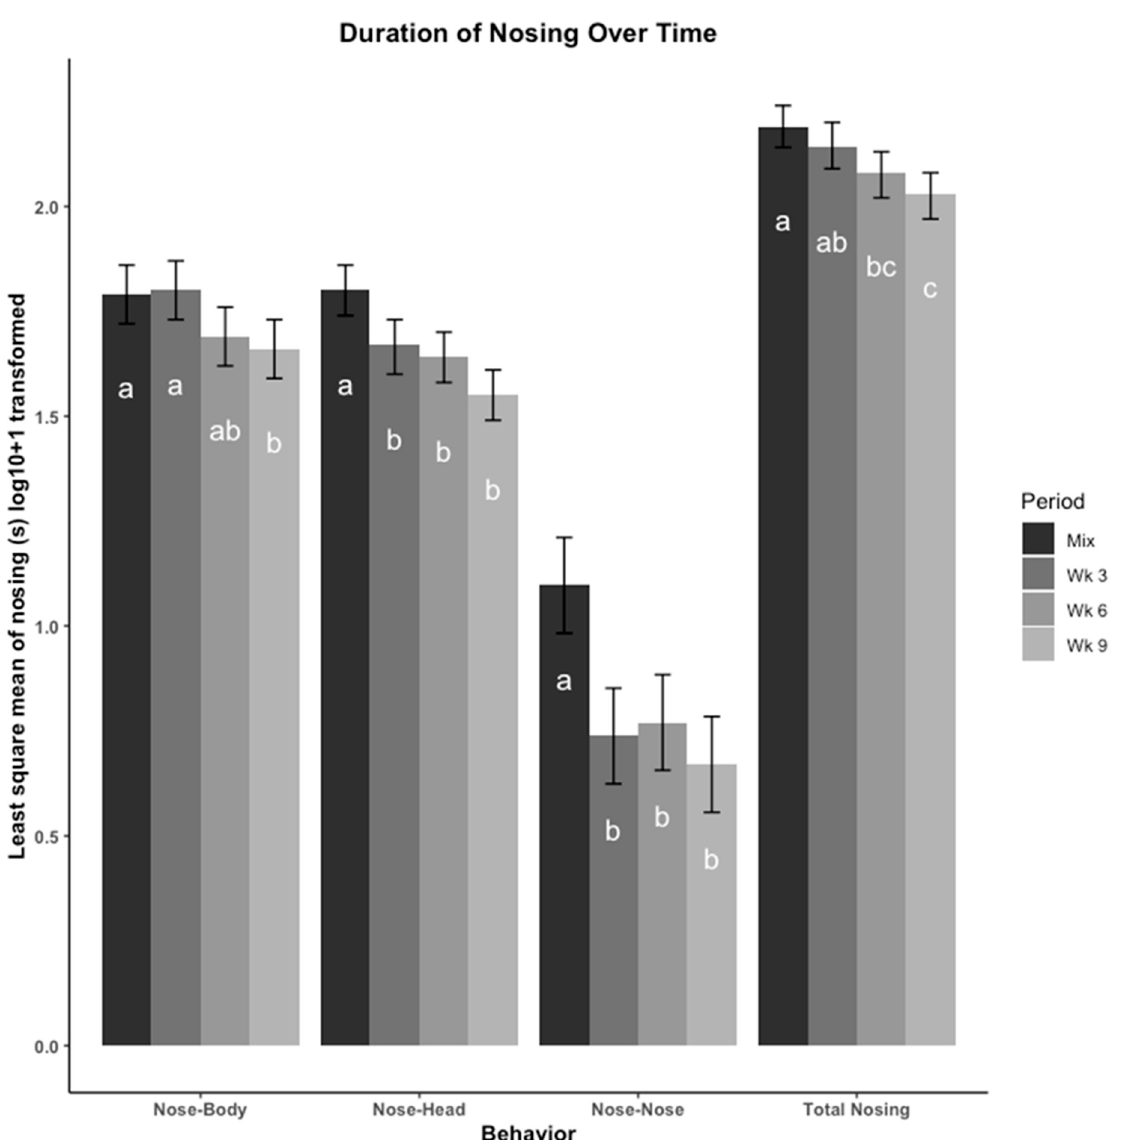
Figure 2. Nosing behaviors were compared across four time points using least square means regres- sion analysis. Nosing behaviors were recorded in duration (seconds (s)) then log 10 + 1 transformed. The four time points are: immediately after mix, and 3, 6, 9 weeks (wk) after mix. Observations at 6 wk were made after pigs were moved to a new pen with their group. Nosing is presented as total duration (s) of each type of nosing (nose-head, nose-body, nose-nose) depending on what part of the body the initiator pig’s nose was touching. Errors bars represent the 95% confidence interval of the least square means. a–c: Bars with different letters denote time periods that showed different frequencies of that behavior ( p < 0.05, Tukey, HSD